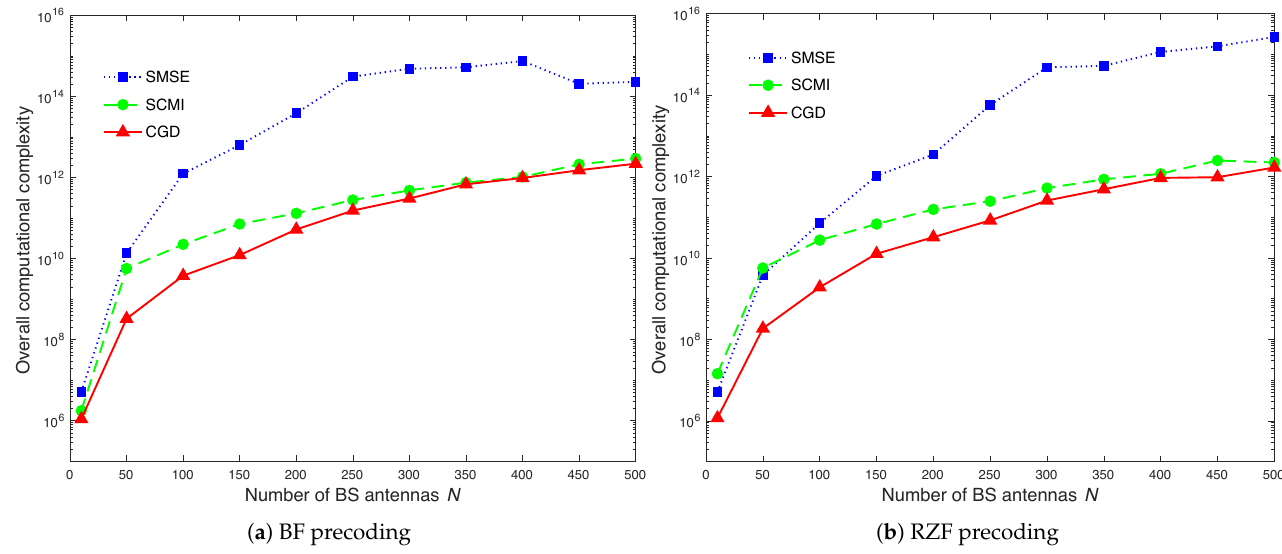
Figure 8. Overall computational complexity versus the number of BS antennas N comparing different training sequence methods corresponding to the pilot length in BF and RZF precoding in the OR model with ω = 5 ◦ , D = 1/2, T = 100 symbols, ρ d = 10 dB and K = 12 users. Table 3. The number of iterations per each training sequence algorithm required to converge with respect to the number of BS antennas N for the pilot length in BF and RZF precoding in the OR model with ω = 2.5 ◦ , D = 1/2, T = 100 symbols, ρ d = 10 dB and K = 10